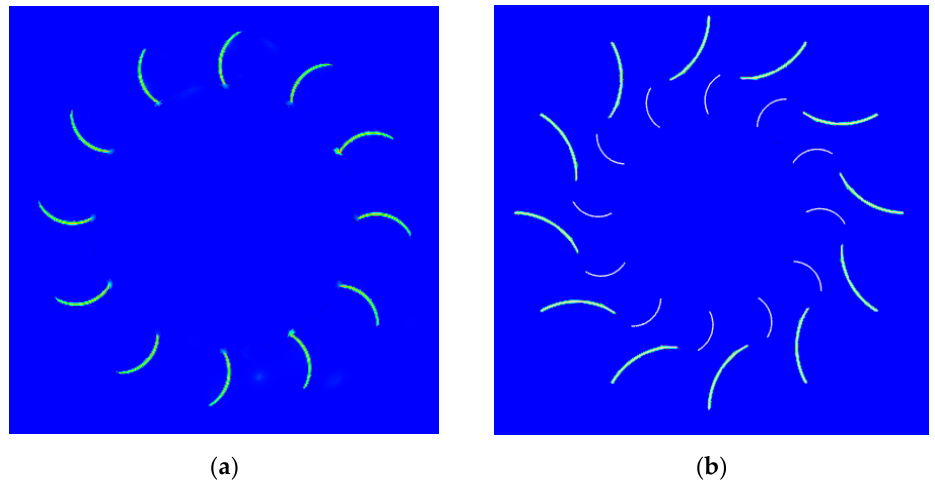
Figure 5. Variations of τ in the vicinity of VAWT ( a ) without stator; ( b ) with stator